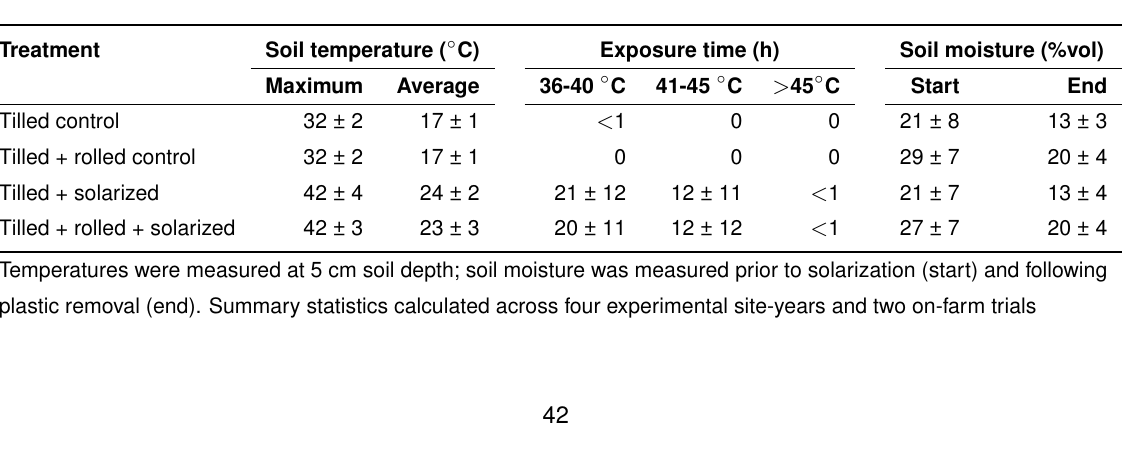
Figure 2. Linear discriminant analyses showing separation of weed communities by treatment along the first two of three linear discriminant (LD) functions (A) during solariza- tion and (B) after solarization. Percent variation explained by each LD function (trace) shown in square brackets. Table 2. Mean ± SD maximum and average soil temperatures, exposure time to temperatures greater than 35 ◦ C, and volumetric soil moisture measured during spring solarization